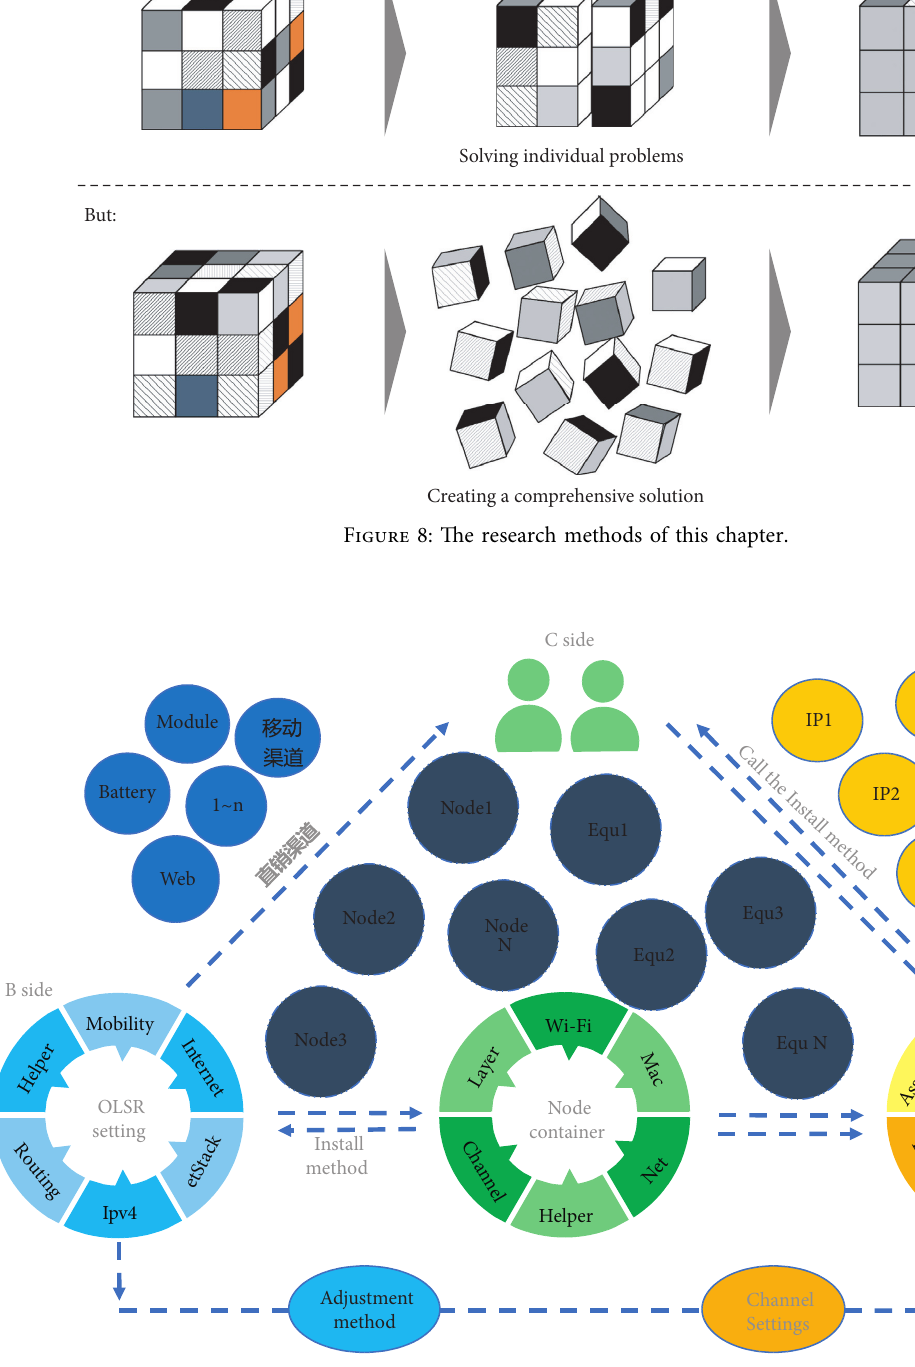
Figure 9: Structure of NS-3.